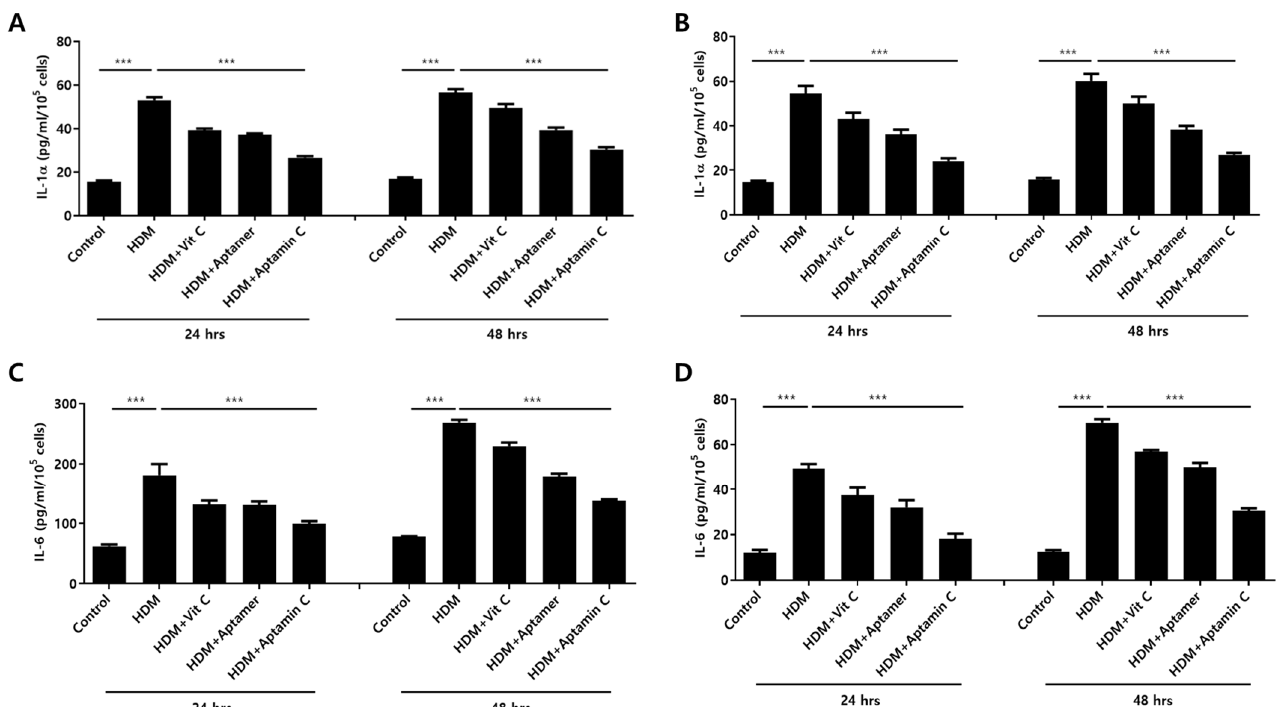
Figure 1. Effects of HDM extract on IL-1 α and IL-6 production by HaCaT and primary keratinocytes, and suppression by Aptamin C. HaCaT ( A , C ) and primary human keratinocytes ( B , D ) were treated with 25 µ g/mL of HDM extract, with or without vitamin C (40 µ M), Aptamin (0.09 µ g/mL), or Aptamin C (vitamin C 40 µ M/Aptamin 0.09 µ g/mL) for 24 or 48 h. The culture supernatants were collected, and the concentrations of IL-1 α ( A , B ) and IL-6 ( C , D ) were evaluated by ELISA as described in Materials and Methods. Data are presented as the mean ± SD. *** p < 0.001.